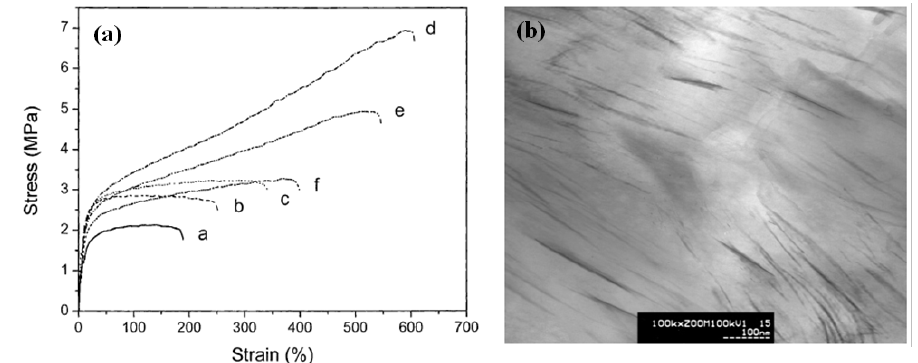
Figure 4. (a) Stress-strain curves for the PU/clay films with different clay contents and tensile properties: (a) 0, (b) 1, (c) 2, (d) 3, (e) 4 and (f) 5 wt %; (b) TEM microphotograph of the PU/clay nanocomposite with 5 wt % clay (adapted from [50]).